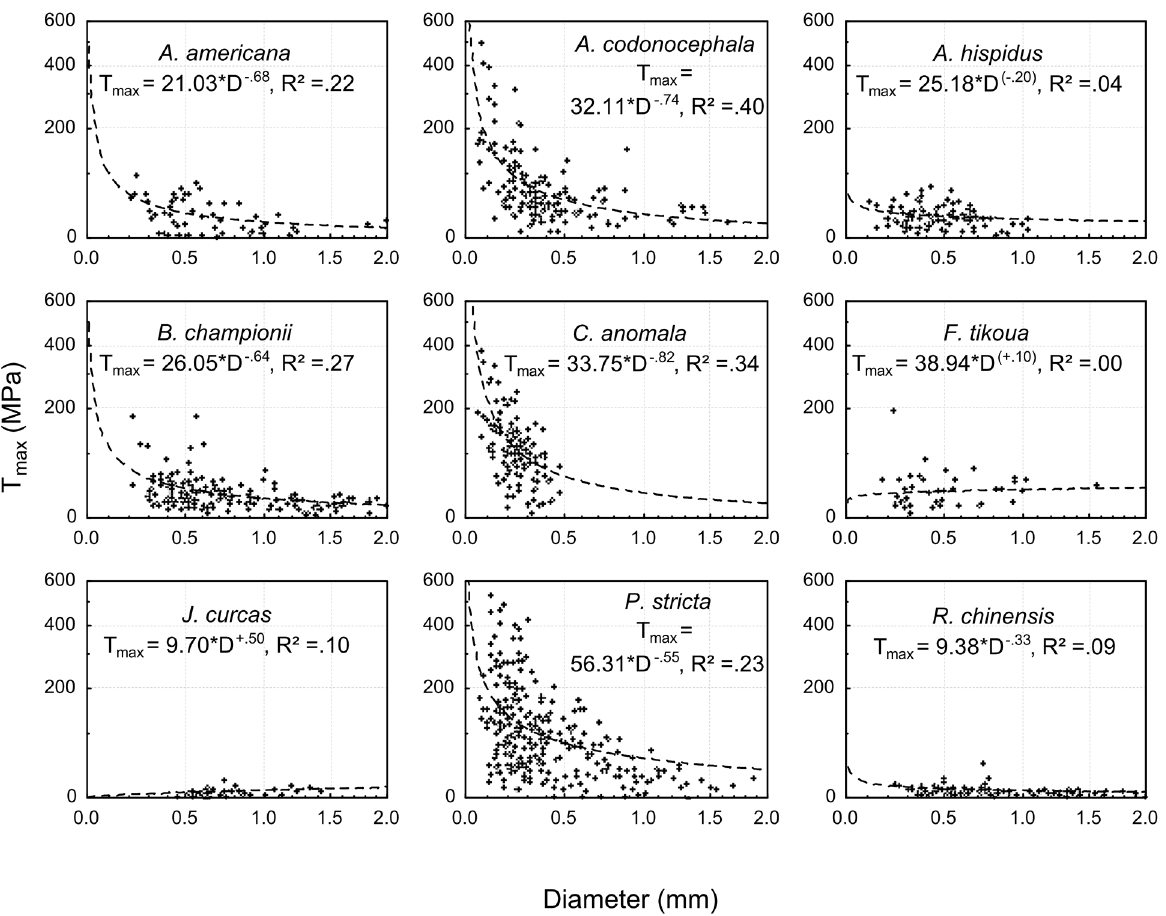
Figure 7. Tensile stress at failure. Tensile stress at failure (T max ) for root diameters from 0 to 2 mm. Logarithmic scales. Fitting curves: T max = a *D 2 b , equations are presented on the graphs with the determination coefficient (R 2 ), parameters in brackets are not